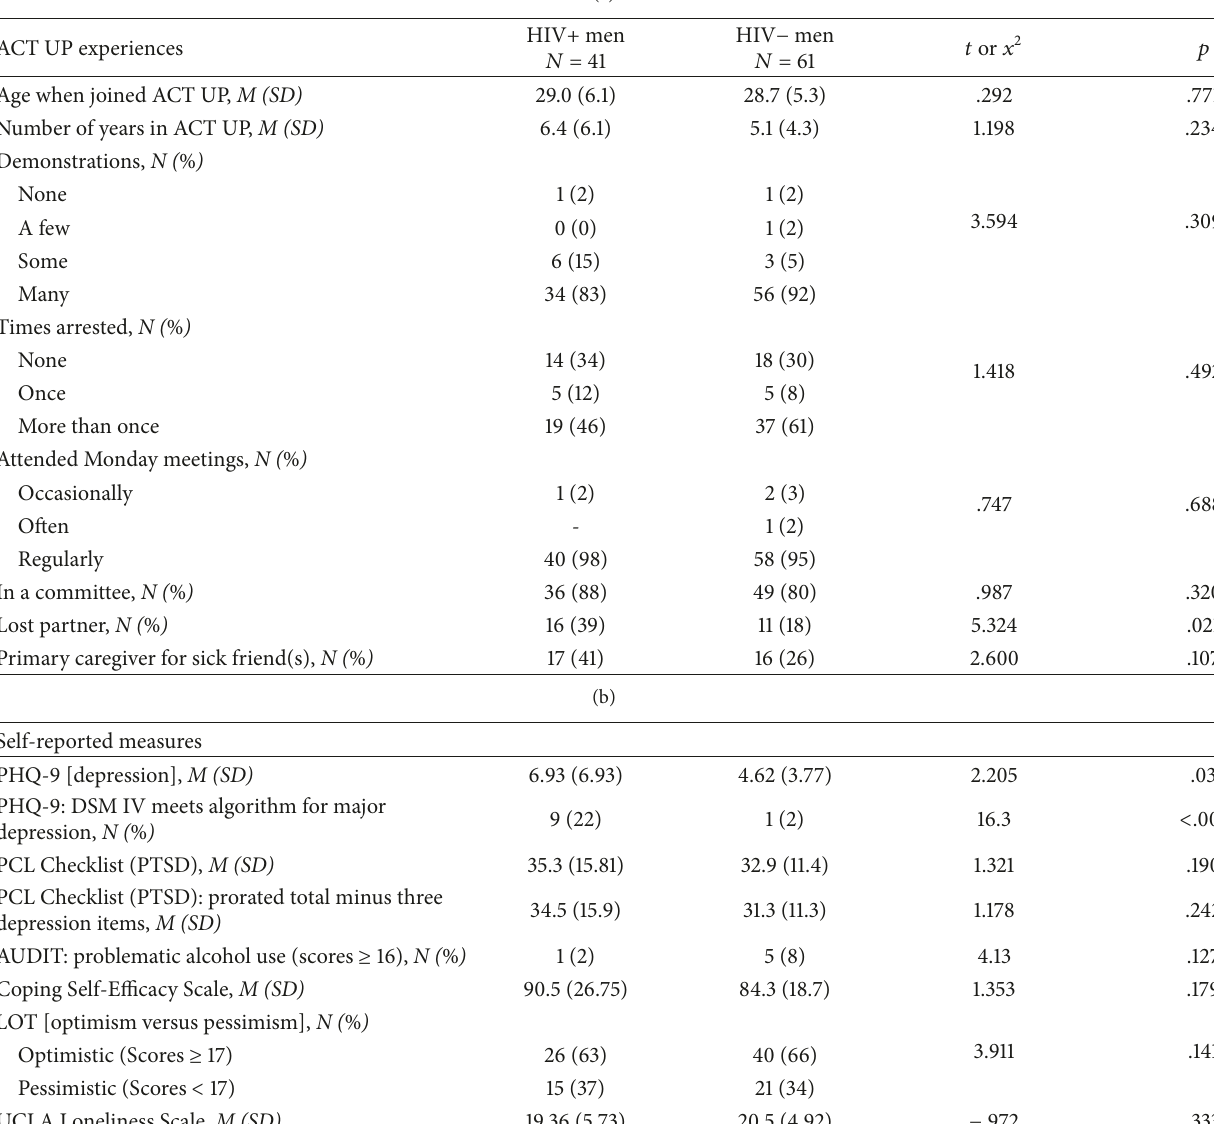
Table 5: Comparison of male ACT UP members by HIV